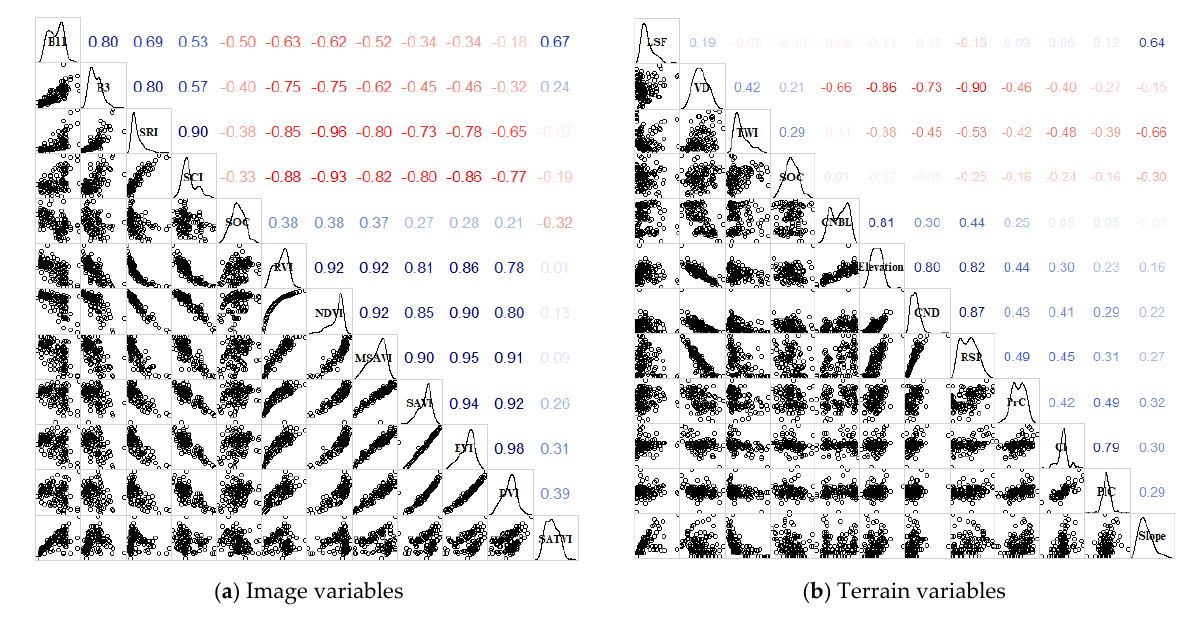
Figure 2. Variable Pearson correlation coefficient matrix. Notes: The diagonal line indicates the variable names and distribution density curves, the upper diagonal panel is the correlation coefficient matrix, and the lower diagonal panel is the scatter plot matrix between the variables. SCI, soil color index; SRI, soil red index. RVI, ratio vegetation index; DVI, difference vegetation index; NDVI, nor- malized difference vegetation index; EVI, enhanced vegetation index; SAVI, soil-adjusted vegetation index; MSAVI, modified soil-adjusted vegetation index; SATVI, soil-adjusted total vegetation index. CNBL, channel network base level; CND, channel network distance; CI, convergence index; PlC, plan curvature; PrC, profile curvature; TWI, topographic wetness index; VD, valley depth; RSP, relative slope position; LSF, length–slope factor.